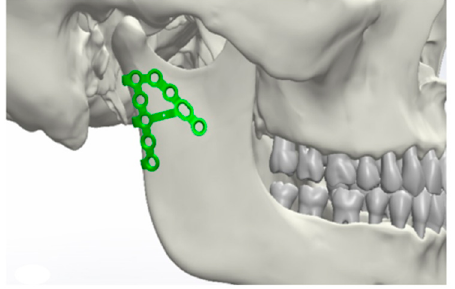
Figure 1. Positioning of the osteosynthesis plates in the area of the condyle.